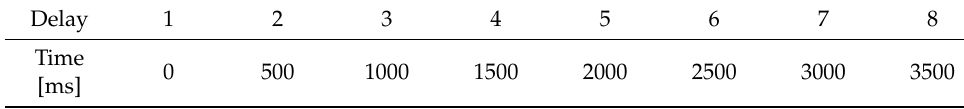
Table 3. Non-electric detonator delay times used during blasting.